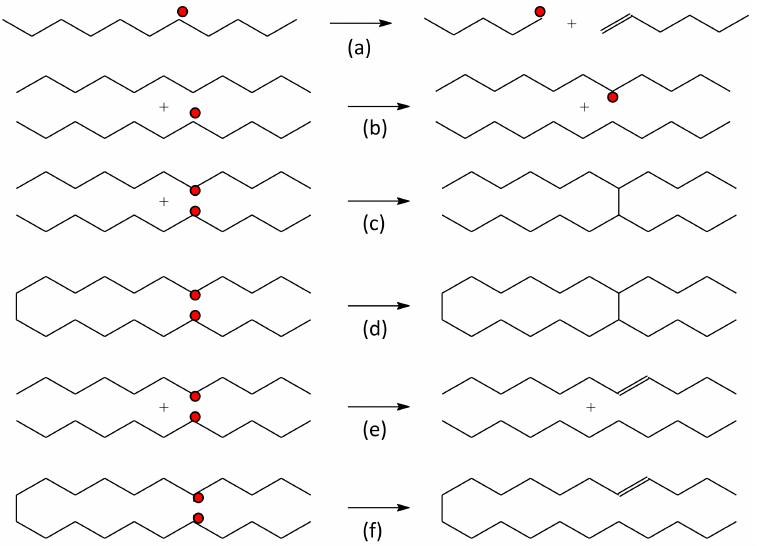
Figure 2. Schematic of general polymer radical reactions: ( a ) degradation reaction, ( b ) H-atom shift, ( c ) intermolecular crosslinking, ( d ) intramolecular crosslinking (basis of nanogel formation), ( e ) in- termolecular disproportionation, ( f ) intramolecular disproportionation. Adapted with permission from [54]; published by International Atomic Energy Agency,